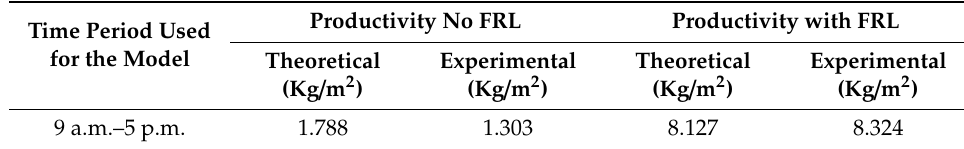
Figure 7. Hourly variation of experimental and theoretical values of glass temperatures. Table 5. Cumulative water productivity comparison between experiments and theoretical model. Productivity No FRL Productivity with FRL Time Period Used for the Model Theoretical Experimental Theoretical Experimental (Kg / m 2 ) (Kg / m 2 ) (Kg / m 2 ) (Kg / m 2 ) 9 a.m.–5 p.m. 1.788